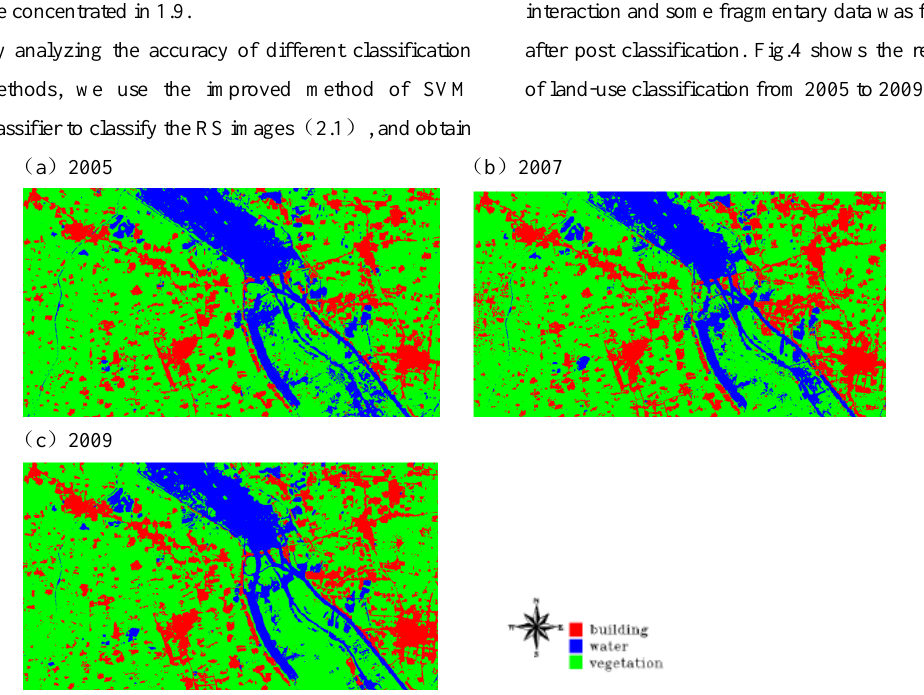
Fig.4. Land use maps of the study area in Peixian